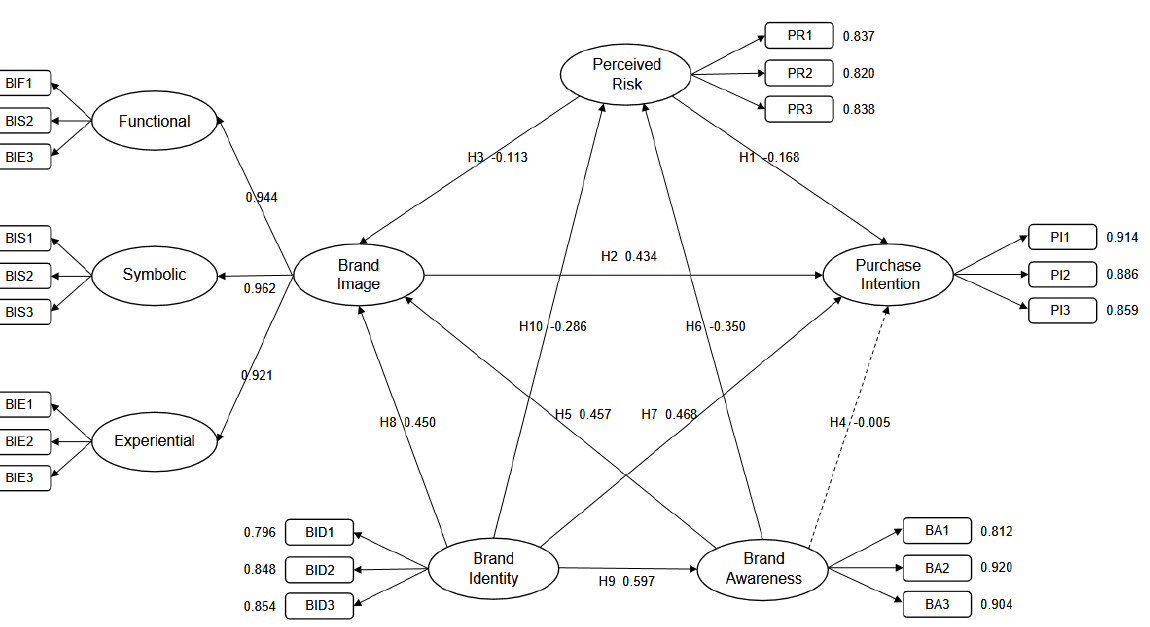
Figure 2. The influence between variables in the structural model. Based on the SEM verification and various test results, the hypotheses